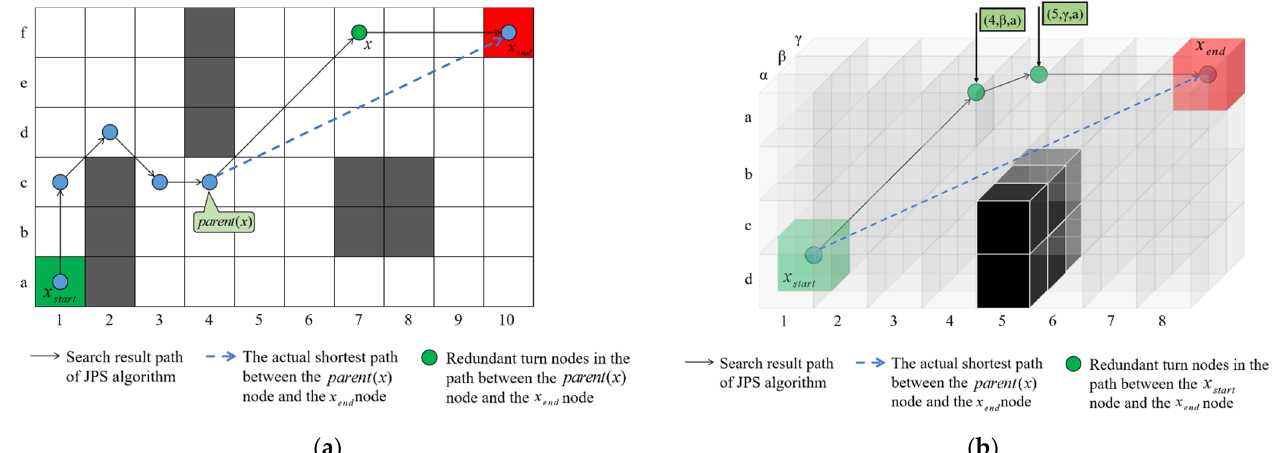
Figure 11. Comparison between the actual spatial shortest path and the path obtained by JPS algorithm. ( a ) Comparison of the actual spatial shortest path and the path obtained by the 2D ‐ JPS algorithm. ( b ) Comparison of the actual spatial shortest path and the path obtained by the 3D ‐ JPS algorithm.